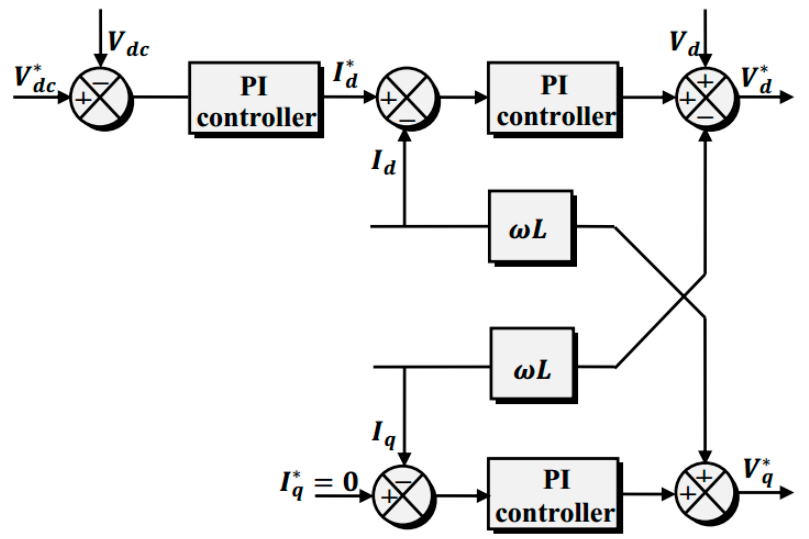
Figure 7. Compensation of the axis’ cross coupling.